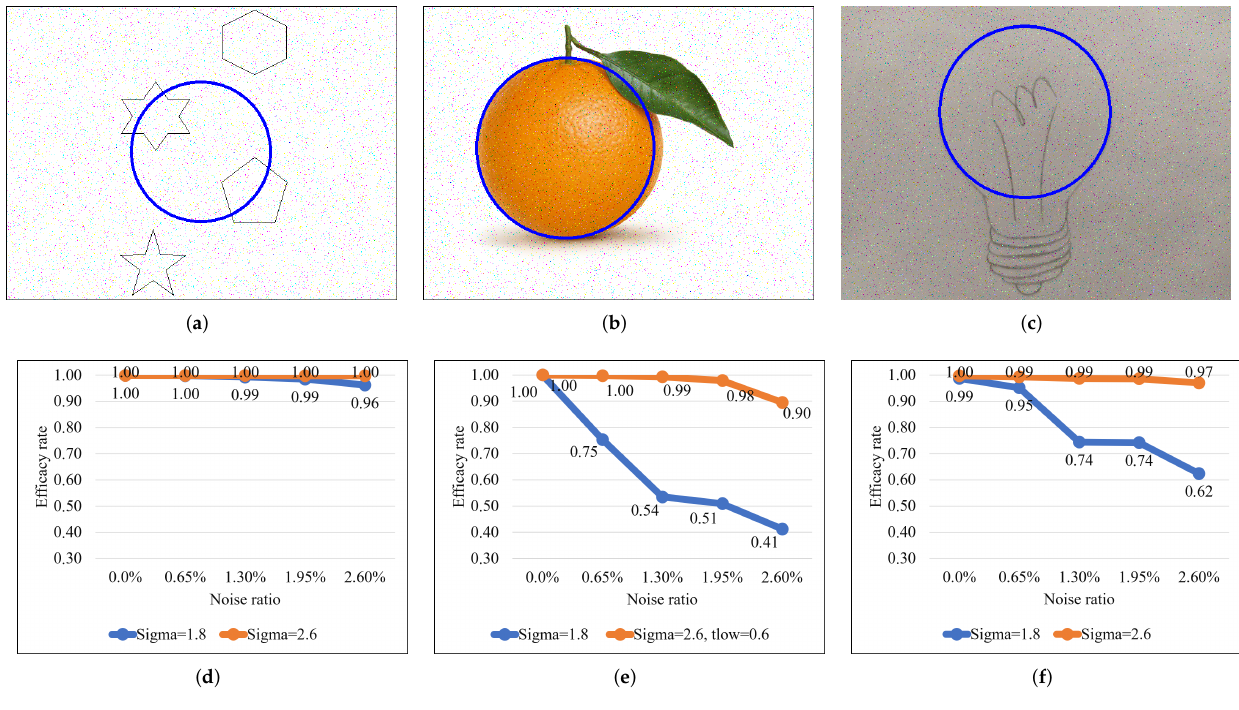
Figure 18. Figure 12a,f,k corrupted with a 2.6% “salt and pepper” noise ratio ( a – c ) and their corre- sponding hit rate trend responses to that noise level evaluating the system under 2 different sets of input parameters ( d – f